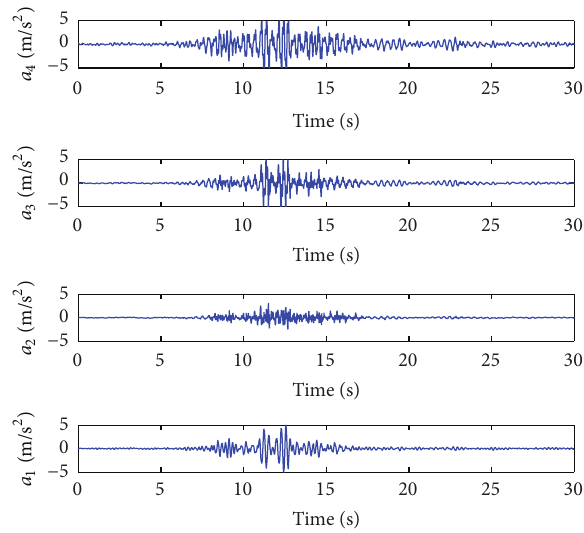
Figure 11: Measured acceleration responses for Case 4.